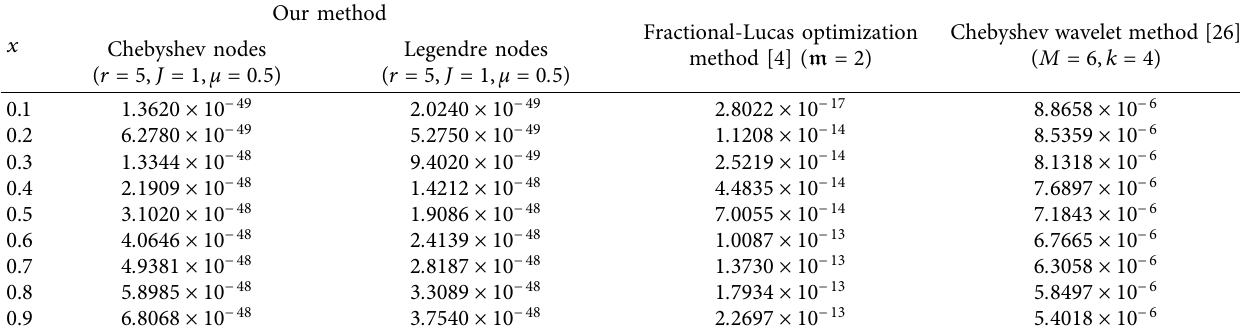
Table 1: Comparison of the absolute error for Example 1.